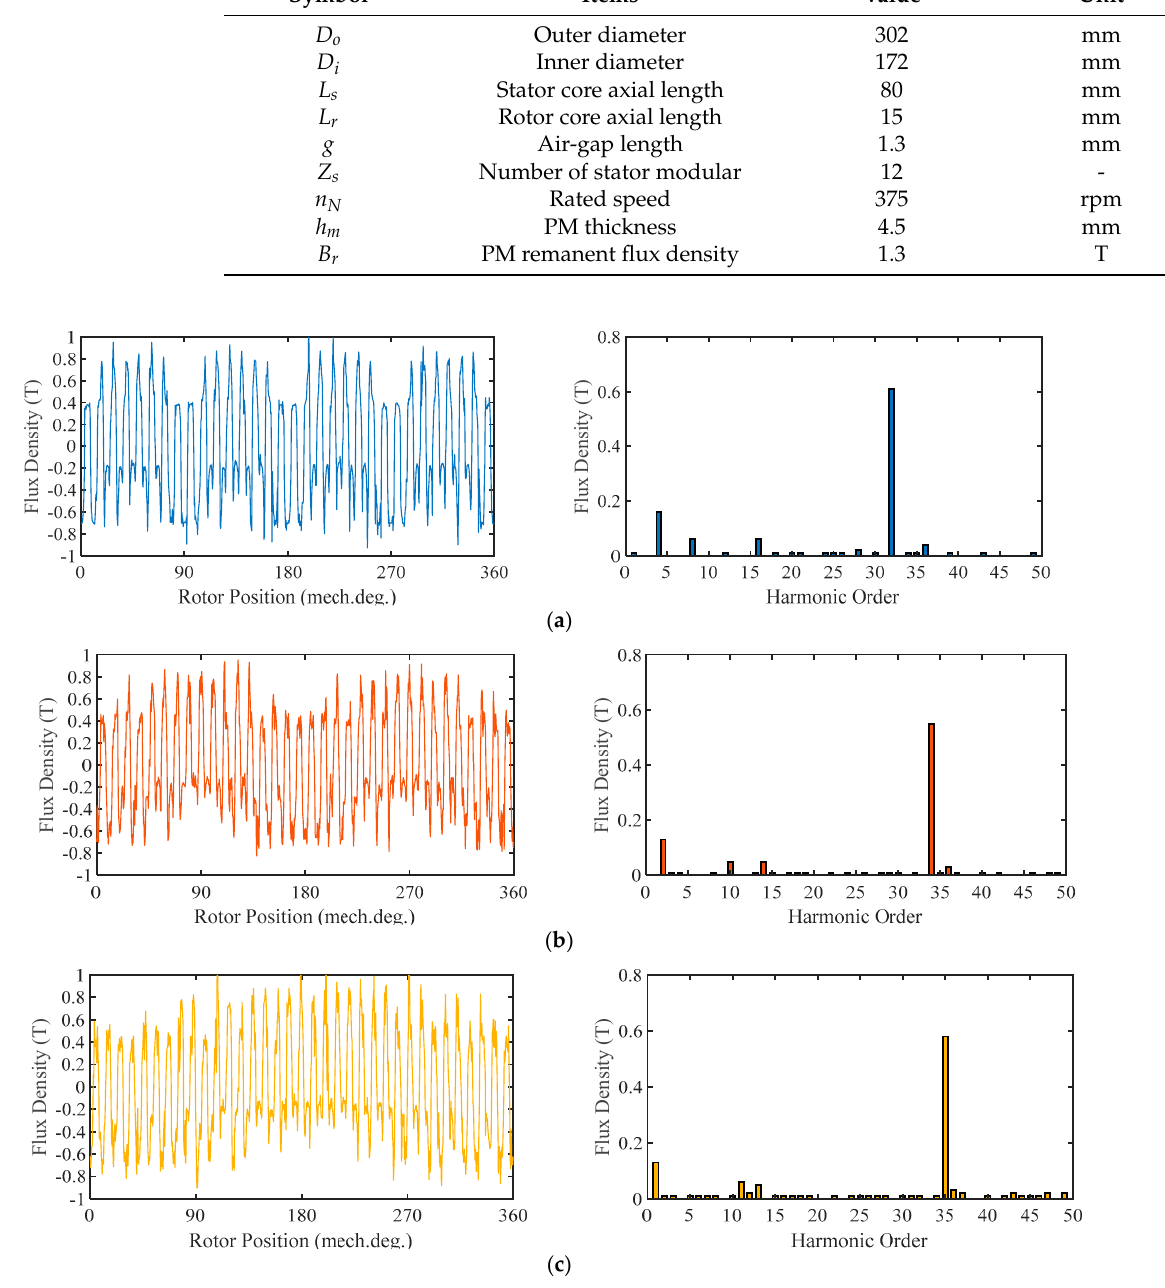
Figure 4. Open–circuit air–gap flux density waveforms and harmonic spectra with different PRs. ( a ) PR of 8/1. ( b ) PR of 17/1. ( c ) PR of 35/1.